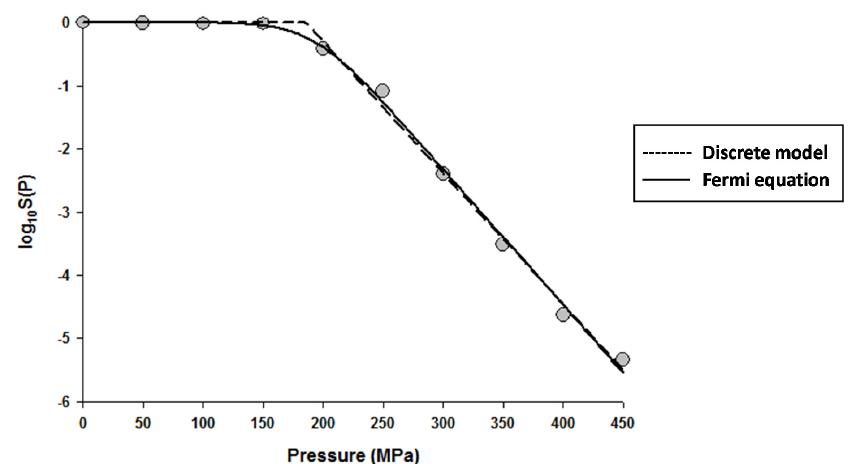
Figure 1. Dose ‐ response curve of Eschericha coli in Luria ‐ Bertani broth exposed to high hydrostatic pressure (HHP) at 25 °C for 10 min. Data were fitted with the Discrete model (dashed lines) and the Fermi equation (solid lines). Original data were taken from Moussa et al. [20].